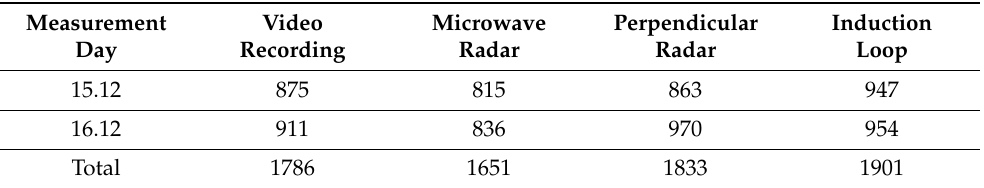
Table 6. List of all vehicles recorded at the Stefana Banacha street point, broken down by applied measurement method (own